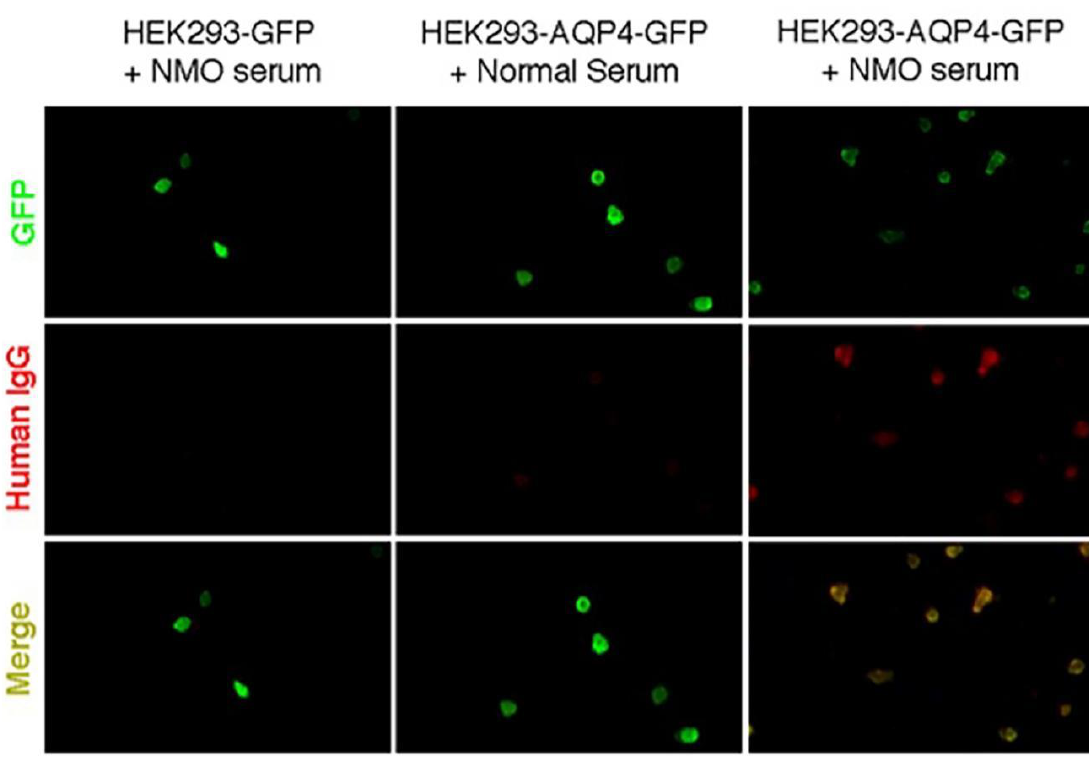
Figure 6. AQP4-GFP-transfected HEK293T cell-based assay of AQP4-IgG in patient serum.